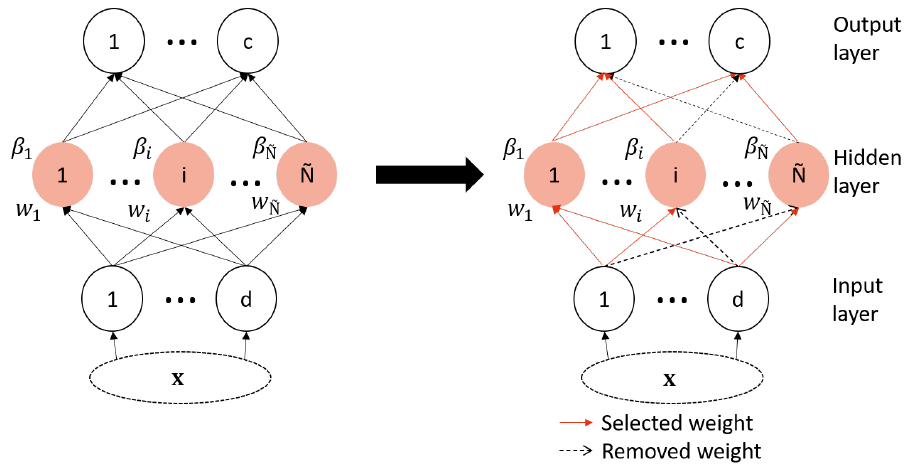
Figure 1. Proposed ELM architecture optimization